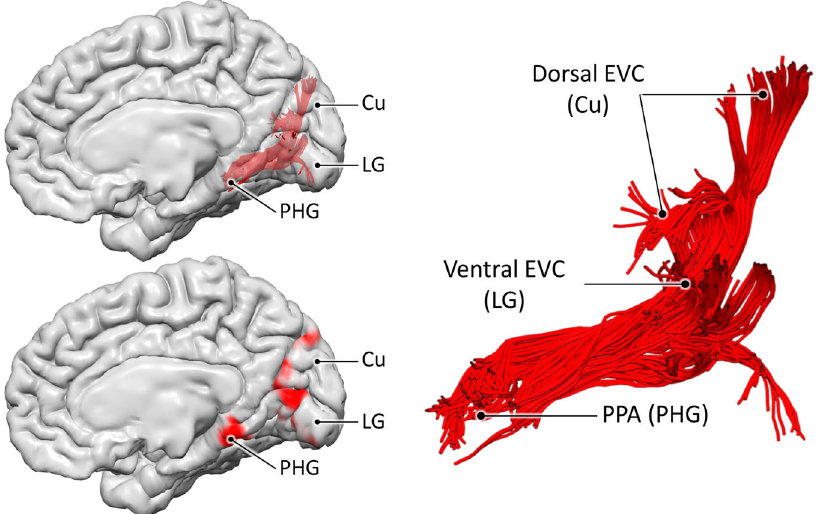
Fig. 5 The medial occipital longitudinal tract (MOLT). Tractography reconstruction of the medial occipital longitudinal tract (MOLT) in an example HCP participant. The MOLT is an occipito-temporal white matter pathway that stems from the anterior cuneus (Cu) and lingual gyrus (LG) and terminates in the posterior parahippocampal gyrus (PHG). In the medial occipital lobe, it projects onto peripheral visual fi eld representations within early visual cortex (EVC), while its temporal lobe terminations overlap the posterior parahippocampal place area (PPA). Further visual representations of the MOLT are available in Supplementary Fig. 5, and descriptive statistics are presented in Supplementary Table